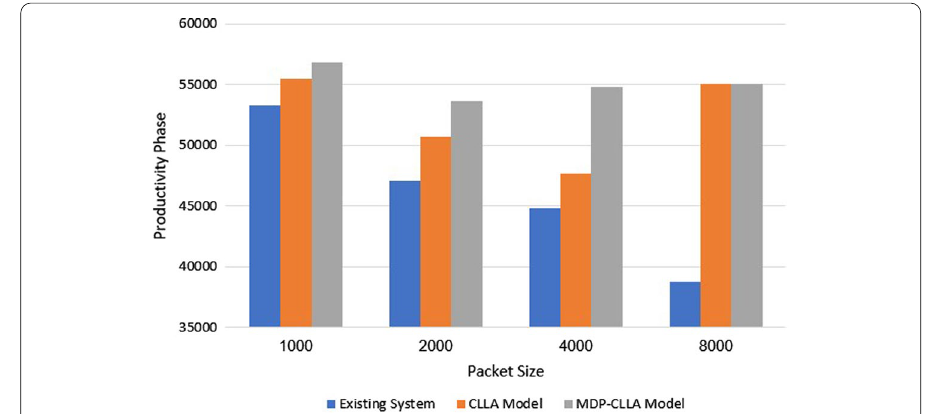
Fig. 15 Phase productivity of models for different packet